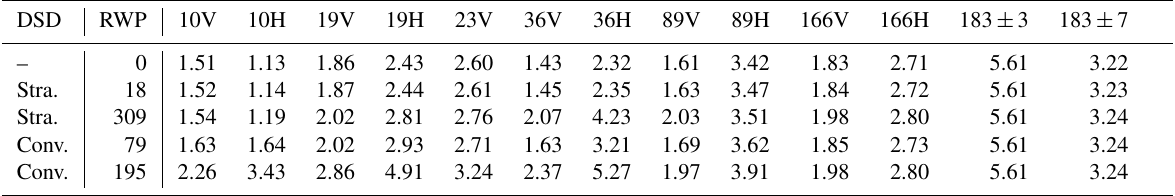
Table 2. GMI channel error variances used during iteration for randomly chosen pixels from the scene in Fig. 7. The square roots of error variances are given so as to be in K, and RWP is given in gm − 2 . The first line (RWP = 0) shows the non-raining algorithm’s error variances. DSD RWP 10V